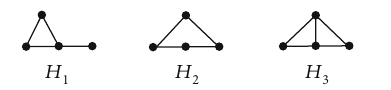
Figure 2: The graphs H Table 1: The eigenvalues of graphs H